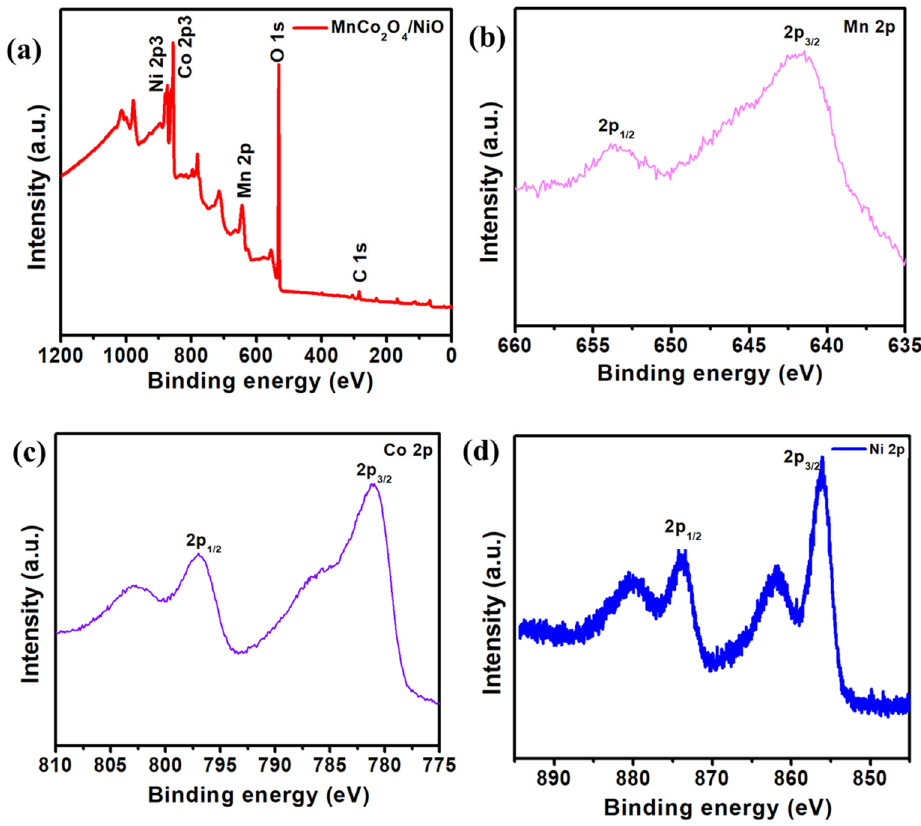
Figure 2. ( a ) XPS survey spectrum of the MCO/NiO composite. High resolution XPS spectra of the ( b ) Mn 2p, ( c ) Co 2p, and ( d ) Ni 2p.